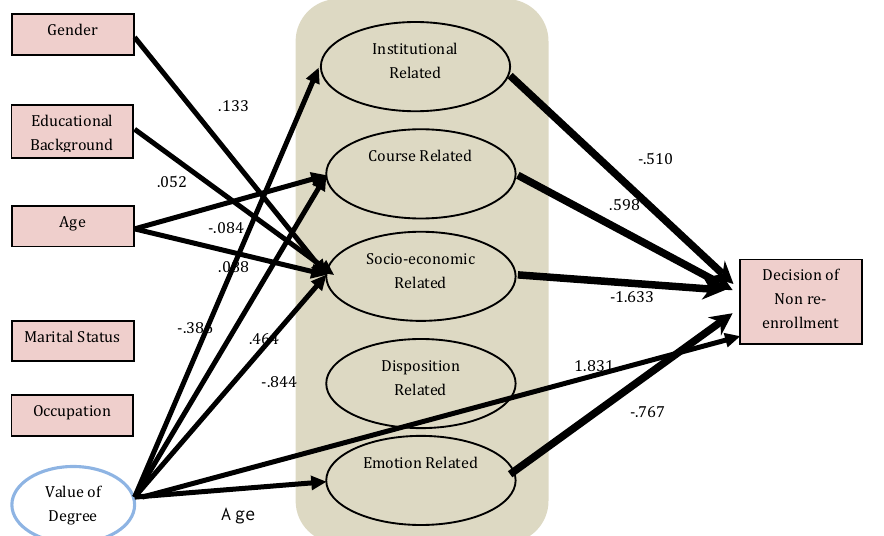
Figure 2. Non re-enrollment